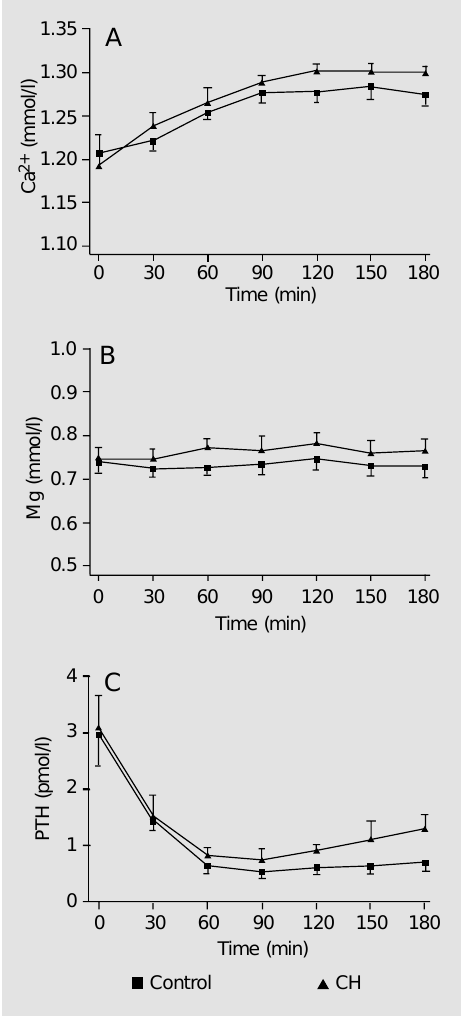
Figure 3. Oral test of parathyroid hormone (PTH) suppression in hypercortisolism. Blood calcium (A), magnesium (B), and PTH concentrations (C) of patients with chronic hypercortisolism (CH) and normal subjects (con- trols), before (time -30, 0) and for 3 h after ingestion of 1 g of elemental calcium. Data are re- ported as means ± SEM. There were no significant differences between